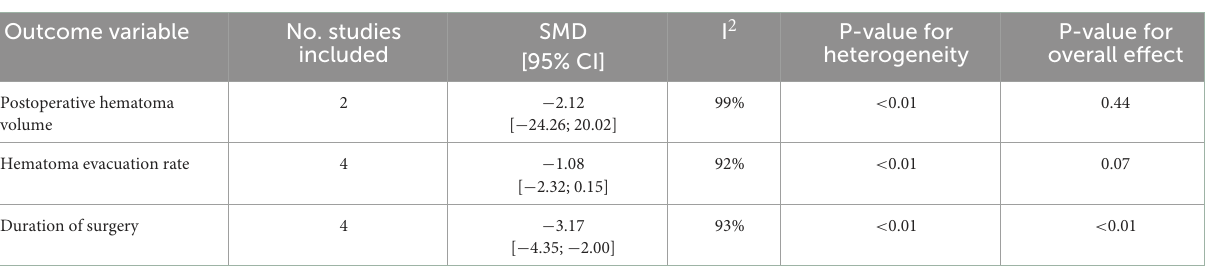
TABLE 3 Results of the meta-analysis for ES compared to